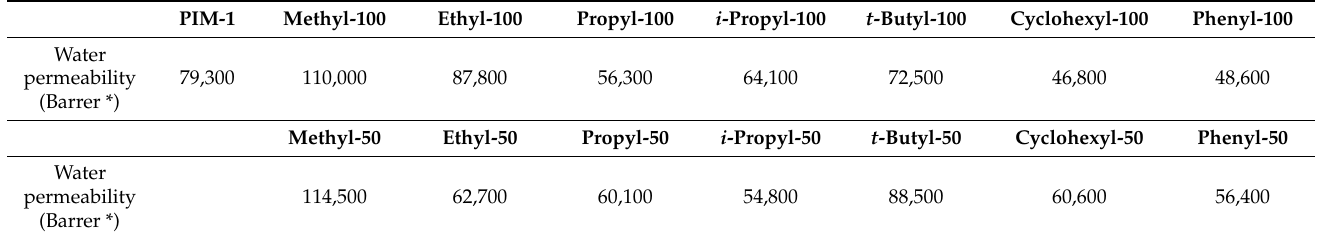
Table 1. Water vapor permeability of homopolymers and